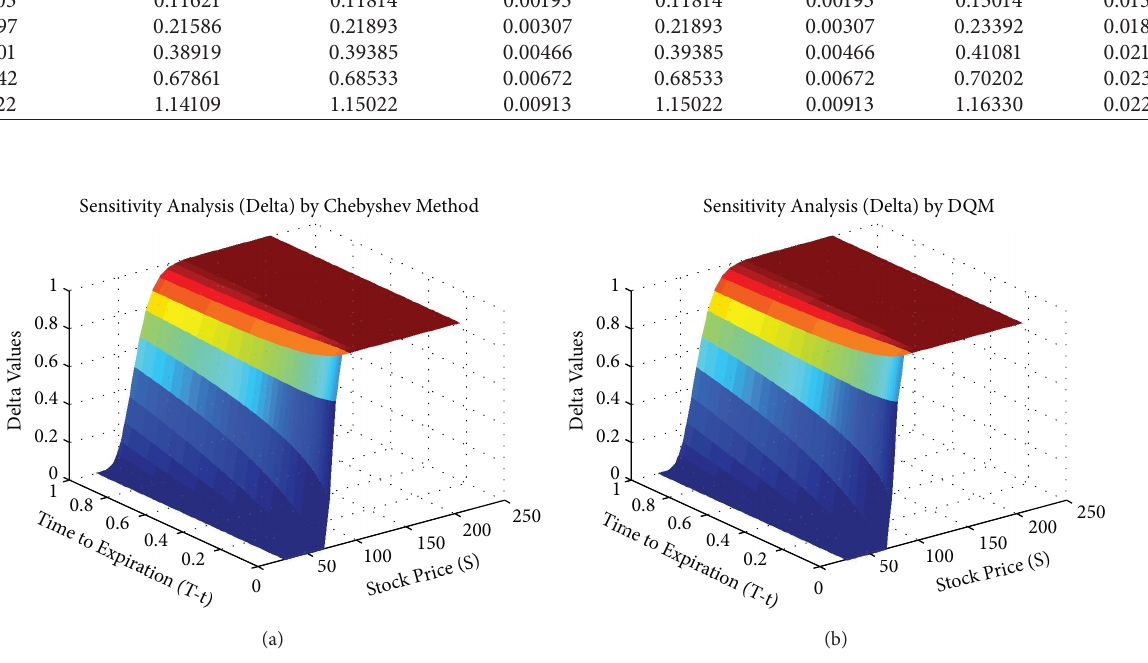
Figure 11: Sensitivity analysis (delta) by Chebyshev spectral method (a) and by differential quadrature method (b).